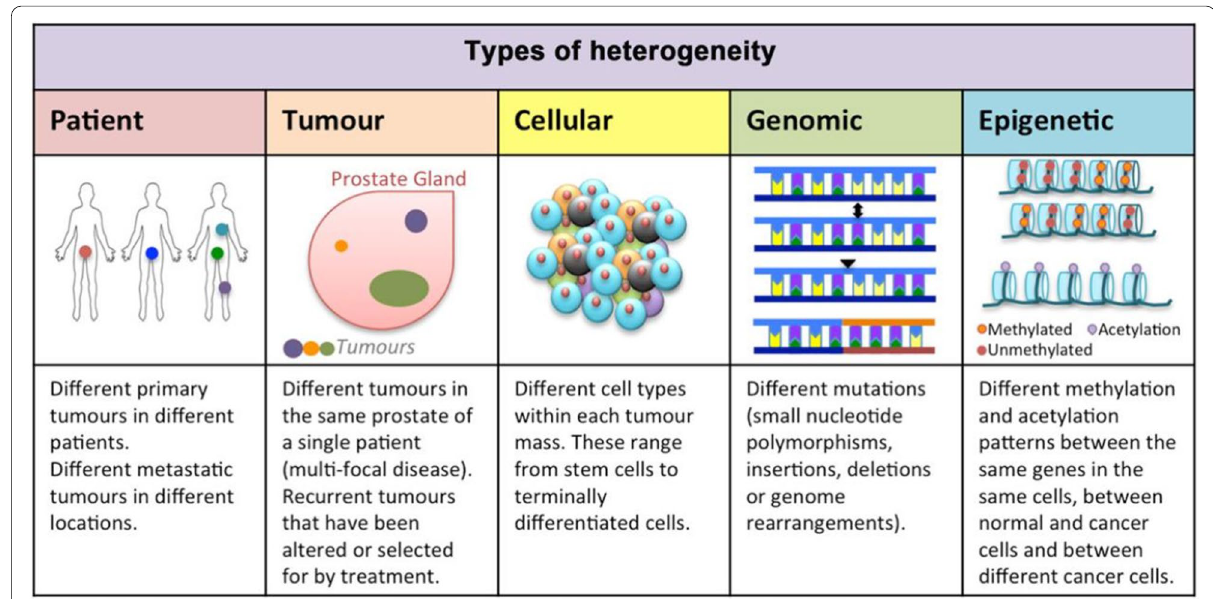
Fig. 5 Multiple types of heterogeneity require consideration when treating cancer patients including patient tumors, multi-focal disease, intra-tumor cellular heterogeneity, genomic heterogeneity, and epigenetic heterogeneity. Reprinted with permission, [119] https:// doi. org/ 10. 20517/ 2394- 4722. 2017.